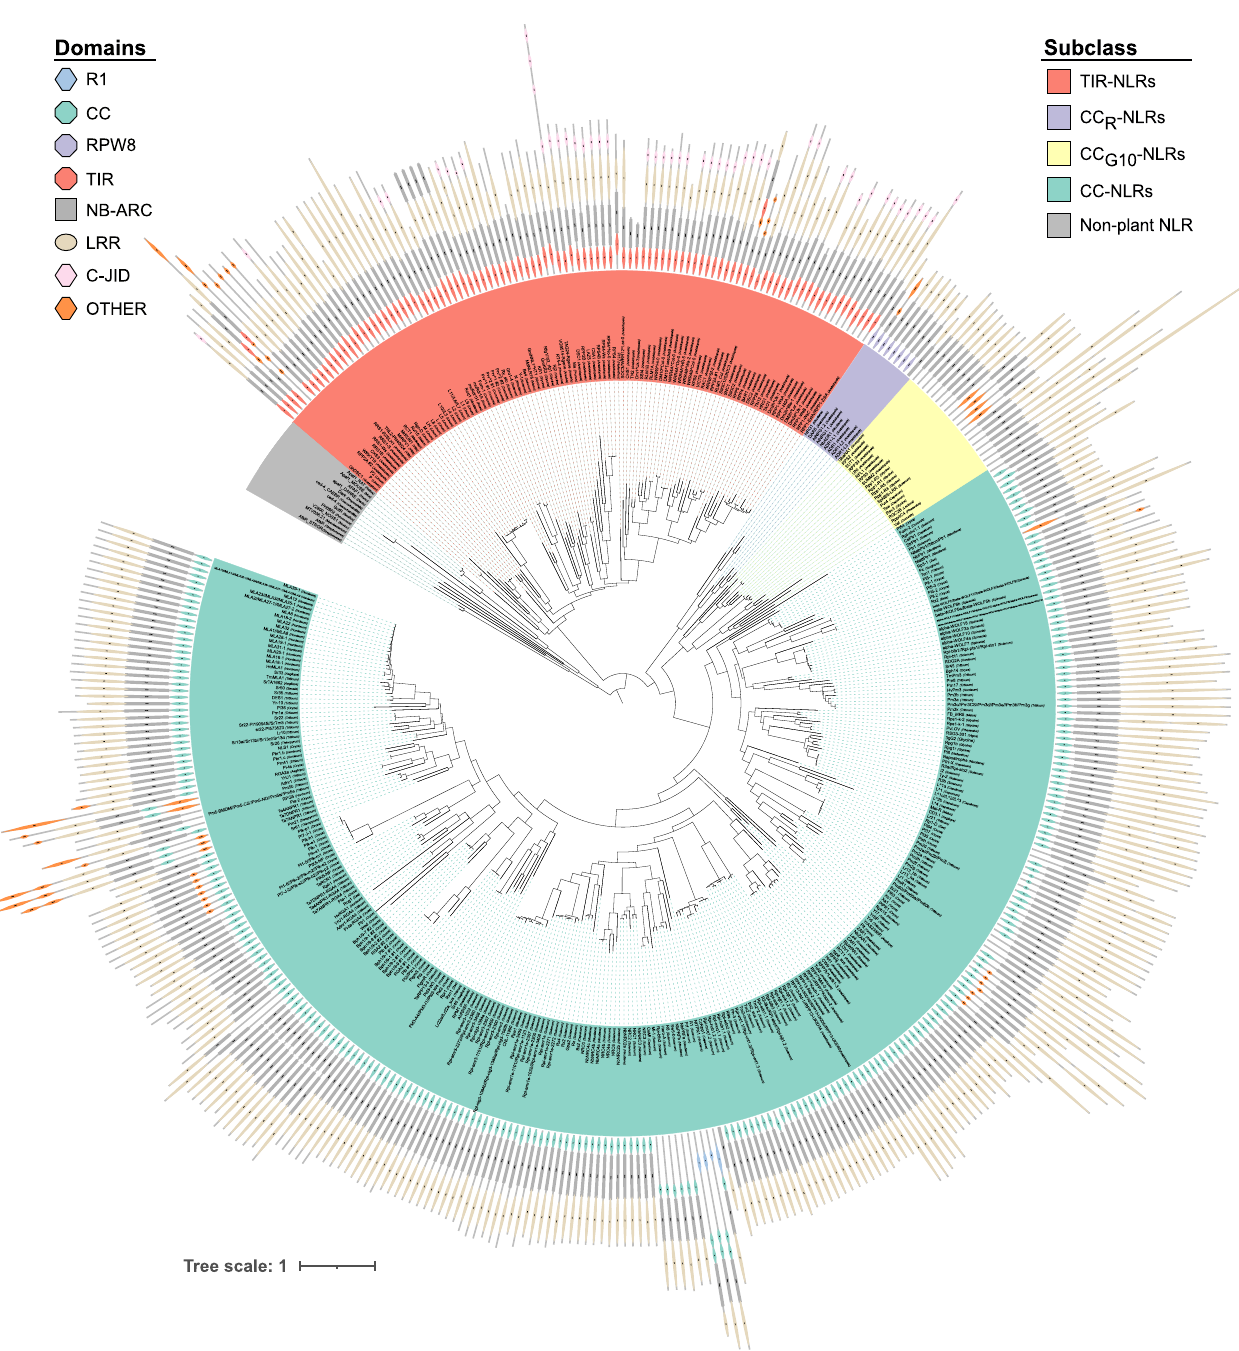
Fig 4. Phylogenetic diversity of RefPlantNLR sequences. The tree, based on the NB-ARC domain, was inferred using the Maximum Likelihood method based on the JTT model [44]. The tree with the highest log likelihood is shown. NLRs with identical NB-ARC domains are collapsed, while for those with multiple NB-ARC domains, the NB-ARC are numbered according to order in the protein. The tree was rooted on the non-plant NLR outgroup. The TIR-NLR, CC-NLR, CC R -NLR, and CC G10 -NLR subclades are indicated. Domain architecture is shown as in Fig 3. CC, coiled-coil; C-JID, C-terminal jelly roll/Ig-like domain; JTT, Jones–Taylor–Thornton; LRR, leucine-rich repeat; NB-ARC, nucleotide-binding adaptor shared by APAF-1, certain R gene products, and CED- 4; NLR, nucleotide-binding leucine-rich repeat; TIR, Toll/interleukin-1 receptor.